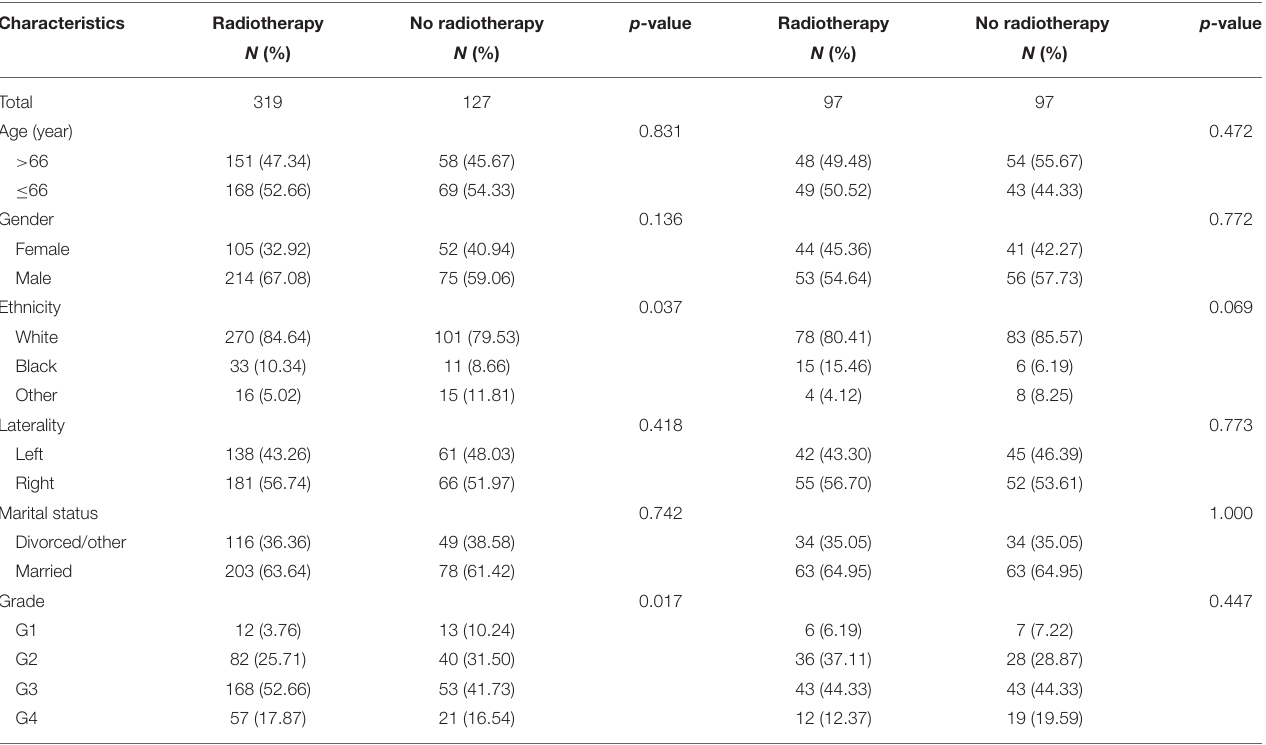
TABLE 3 | Baseline characteristics of patients divided by radiotherapy in the regular and matched groups.